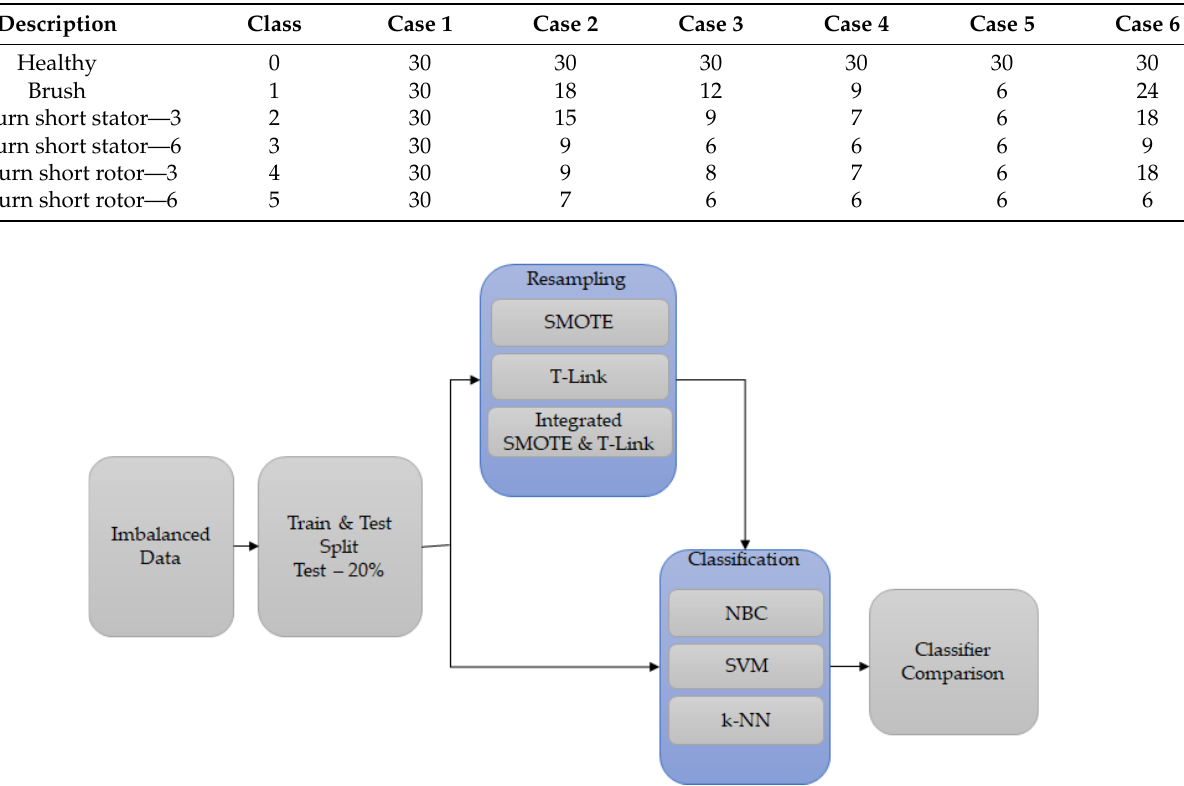
Table 2. Summary of tested cases indicated number of examples per class (or condition on WRIG).